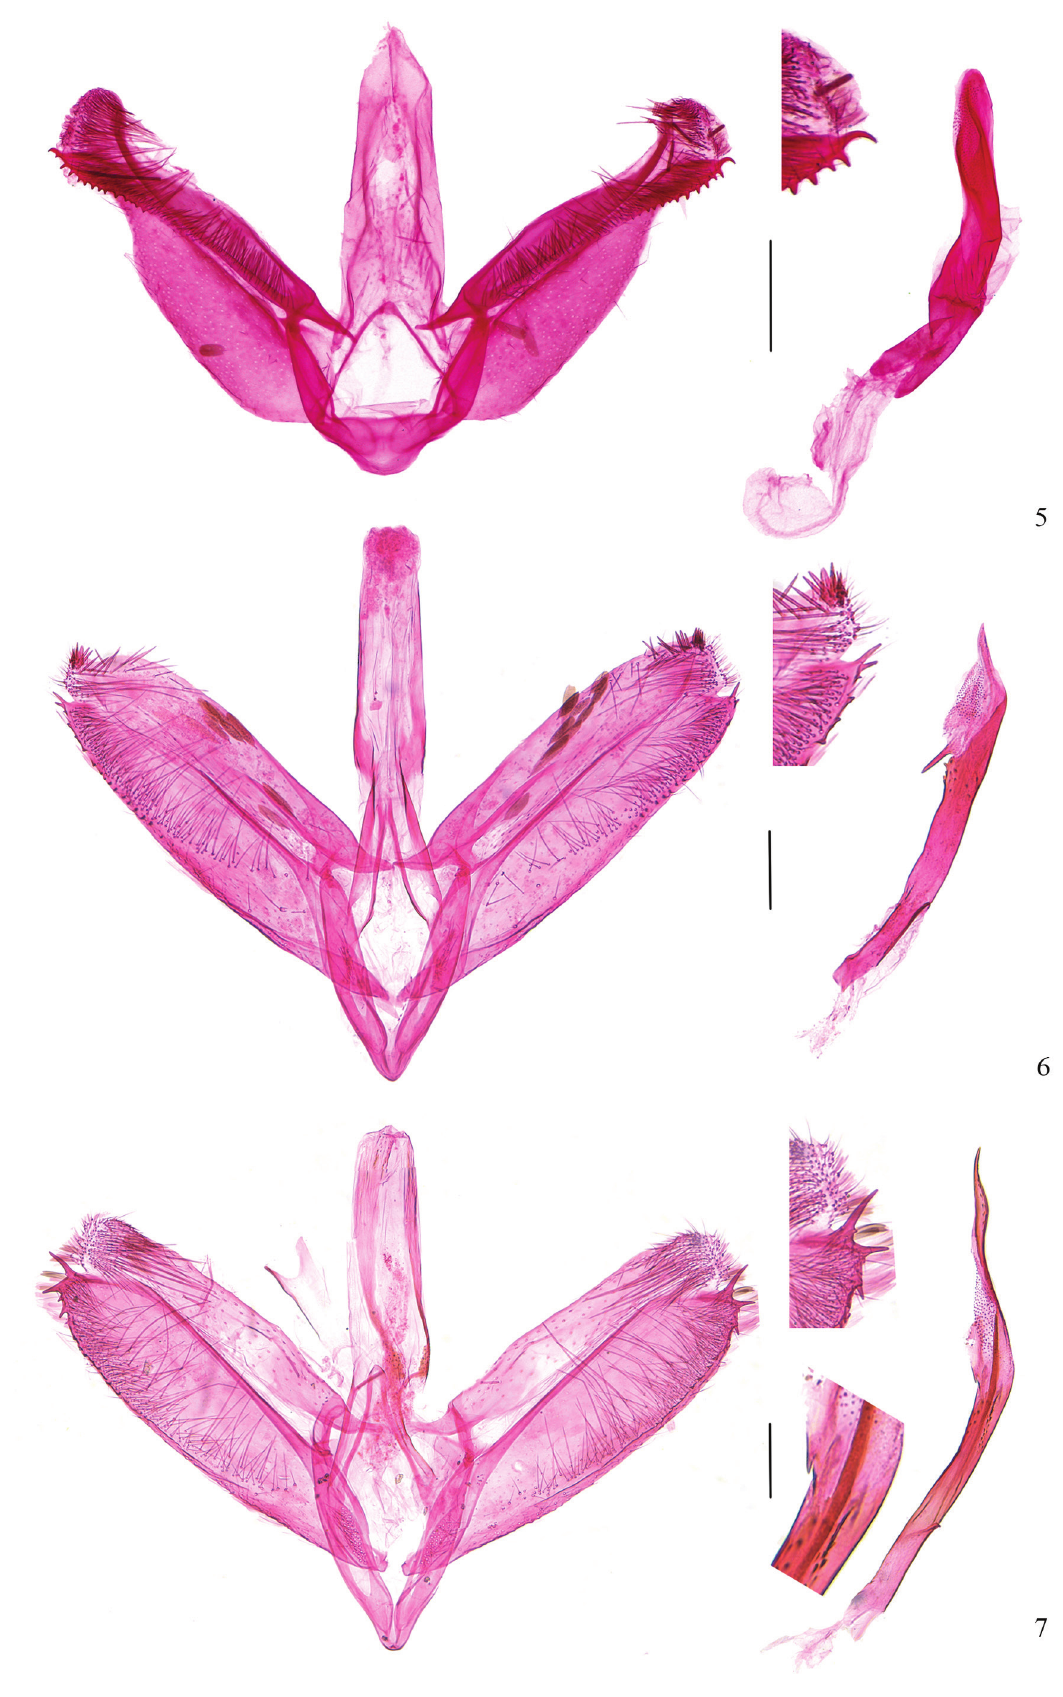
Figures 5–7. Male genitalia of Liocrobyla spp. 5. L. desmodiella , slide no. LTT12611 (NKU); 6. L. lobata , slide no. LIU0028; 7. L. indigofera sp. n., slide no. LIU0030, holotype. Scale bars: 0.2